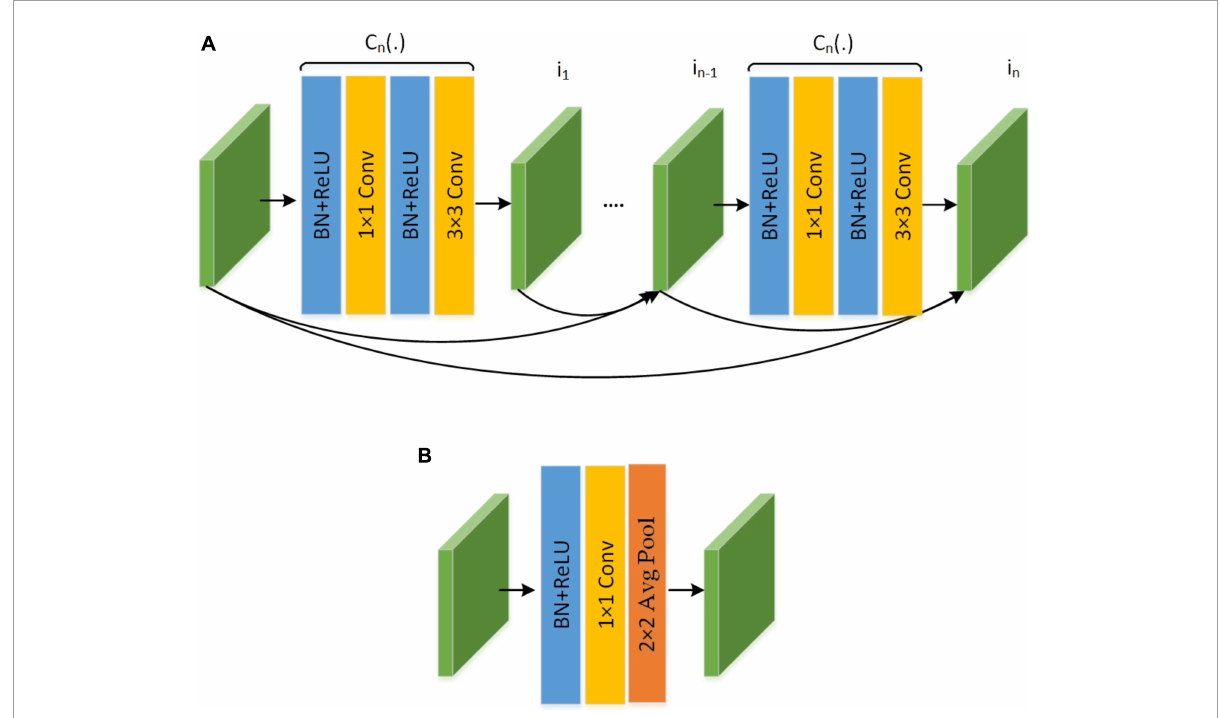
FIGURE3 The pictorial representation of (A) dense block and (B) transition